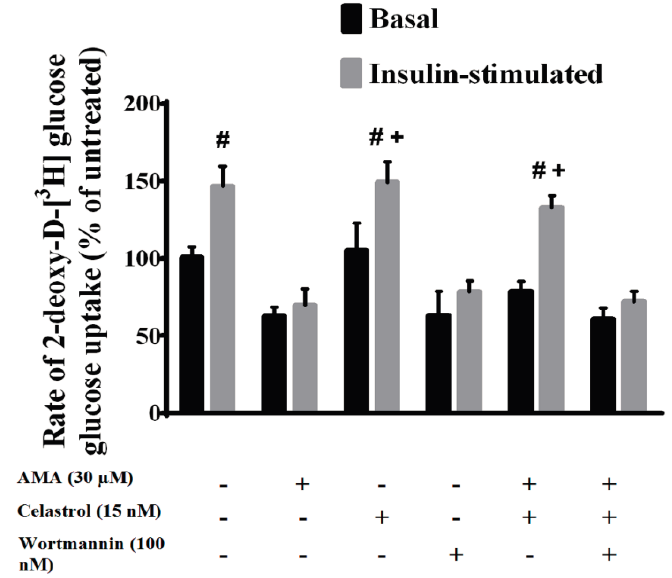
Figure 2. The mechanistic effects of AMA and celastrol treatment on the glucose uptake activity in skeletal muscle cells. Co-treatment with celastrol on skeletal muscle cells with mitochondrial dysfunction for 48 h improved insulin-mediated glucose uptake activity. However, wortmannin blocked this beneficial effects of celastrol on AMA-treated cells. # p < 0.05 vs . basal rate; + p < 0.05 vs . AMA-treated